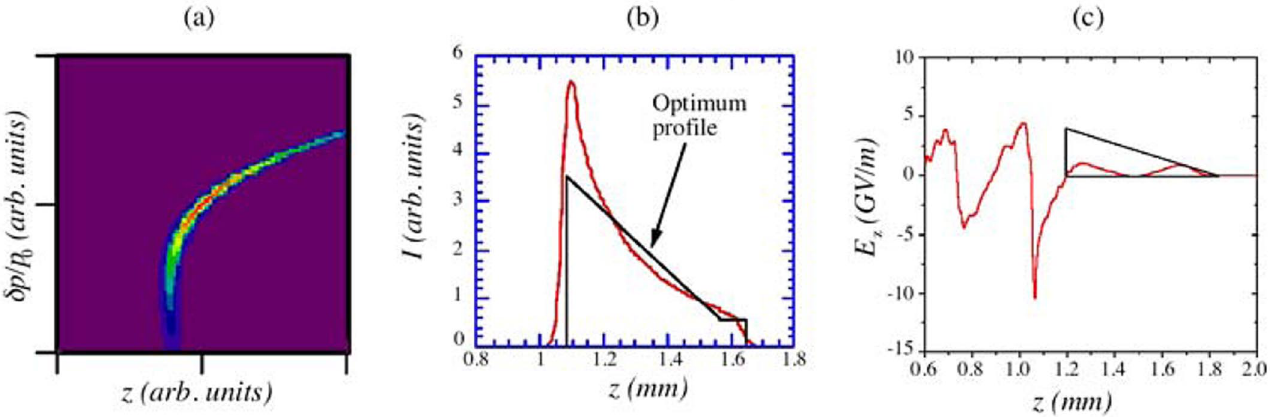
FIG. 2. (Color) Plot showing the longitudinal phase space (a) and density profile (b) of a ramped beam produced by linear dogleg ) compression, as well as a PIC simulation (c) of the wake field produced by such a beam in a plasma of density (negative R 56 2 (cid:17) 10 16 cm (cid:12) 3 , with 6 nC charge.